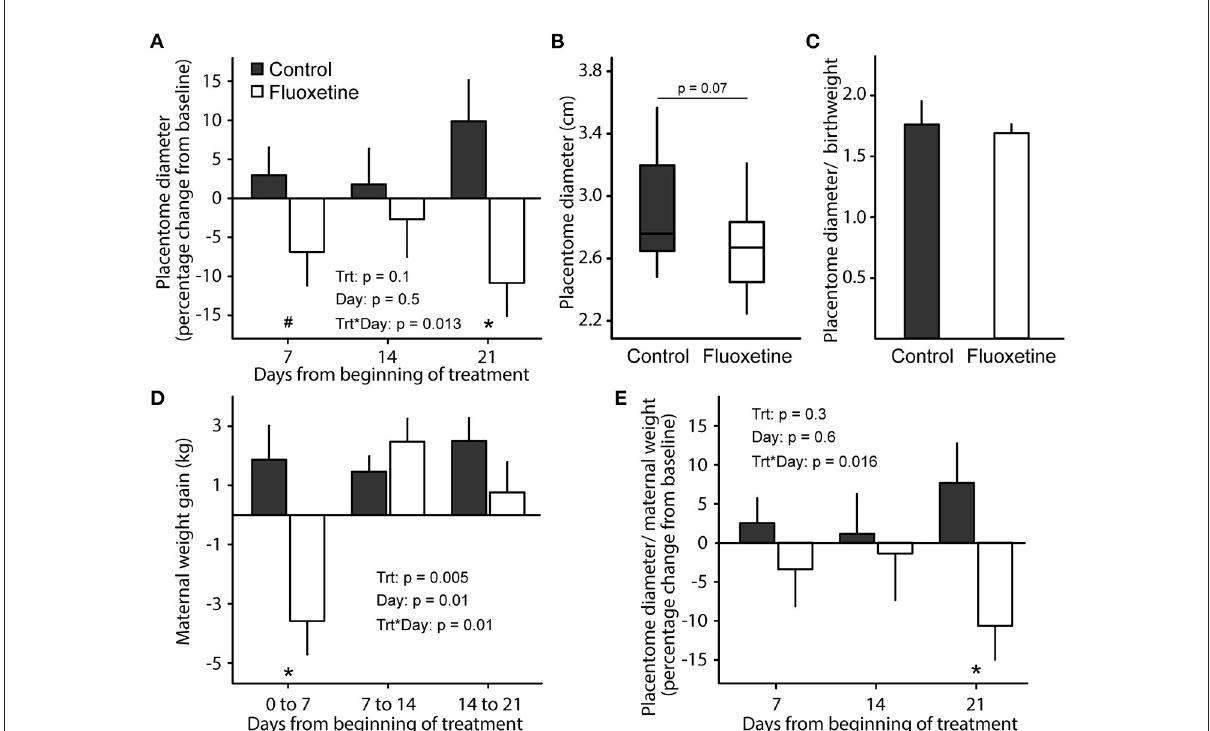
FIGURE2 Placentome diameter. (A) Placentome diameter throughout experimental period relative to pretreatment. (B) Boxplot of placentome diameter on experimental day 21 (gestational day 140 ± 1). Boxplot depicts median, 10th, 25th, 75th, and 90th percentile. (C) Placentome diameter by lamb birthweight ratio. (D) Maternal weight change from baseline. (E) Placentome diameter by maternal weight ratio change from baseline. Baseline maternal weight and placentome diameter were assessed on experimental day − 1 (gestational day 118 ± 1). * indicates significant difference between groups and # indicates a tendency for significance.